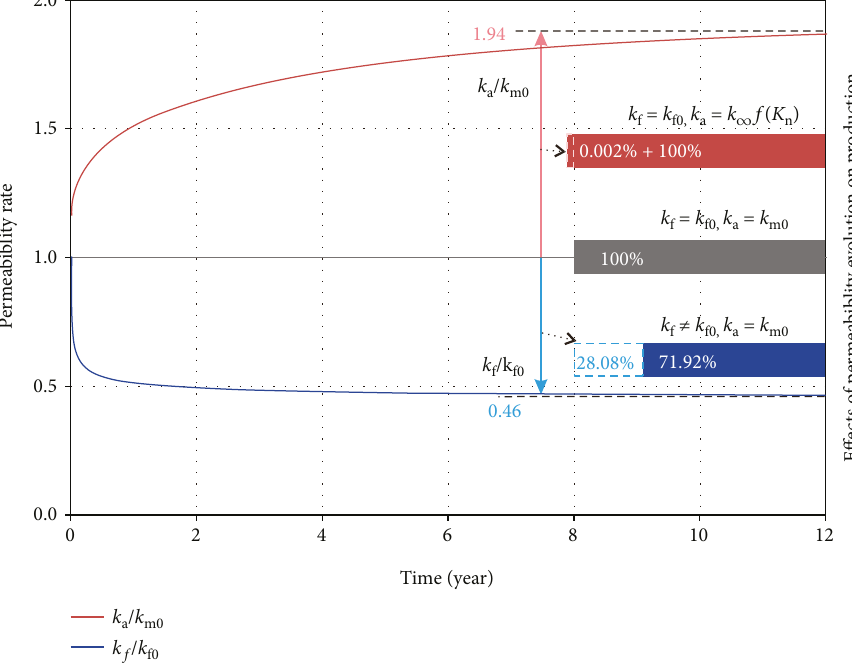
Figure 6: Evolution of matrix and fracture permeability.